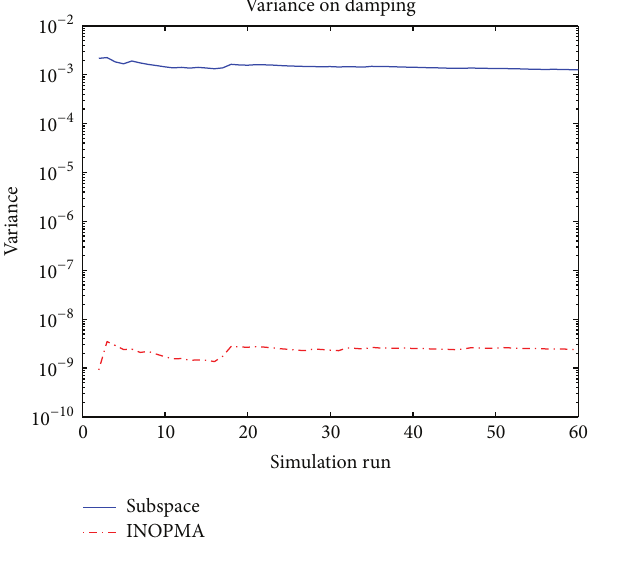
Figure 7: Absolute value of the relative error on the frequency.